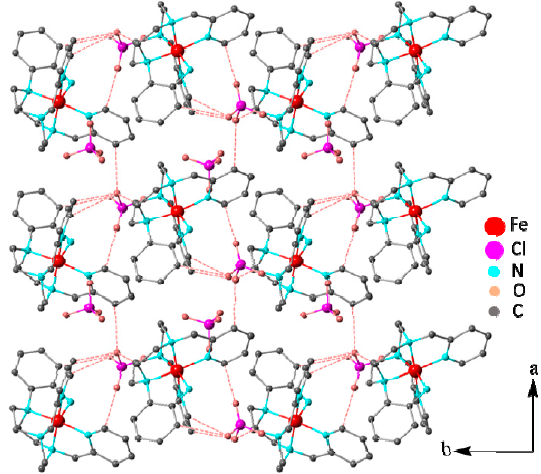
Figure 2. Shortest intermolecular contacts in the ab plane (C···O distances in the range 2.95 – 3.22 Å).